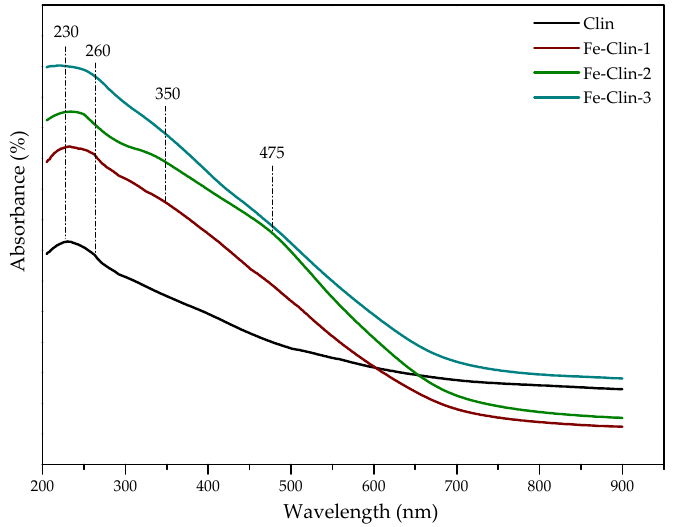
Figure 5. UV–Vis spectra of raw clinoptilolite (Clin) and clinoptilolite modified with different Fe